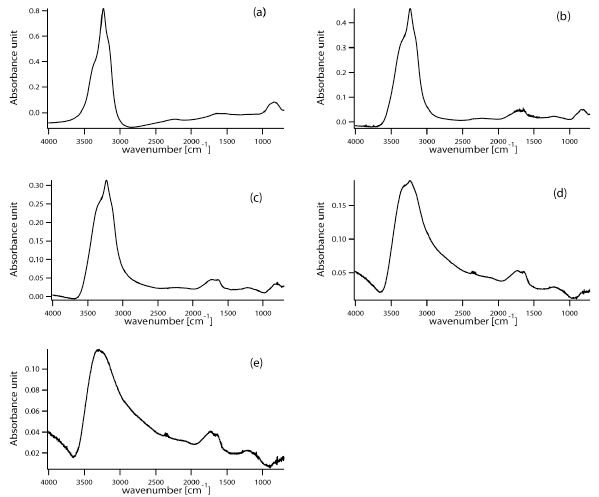
Fig. 8. IR spectra of an amorphous ice/HCl system obtained by Figure 8. IR spectra of an amorphous ice/HCl system, obtained by doping pure ice (a) with HCl vapor doping pure ice (a) with HCl vapor at T >183K. (b) , (c) , (d) and at T > 183 K. (b), (c), (d) and (e) refer to successive scans after doping (260, 510, 650, 780 seconds (e) refer to successive scans after doping (260, 510, 650, 780s, re- respectively) under SFR conditions. spectively) under SFR conditions.